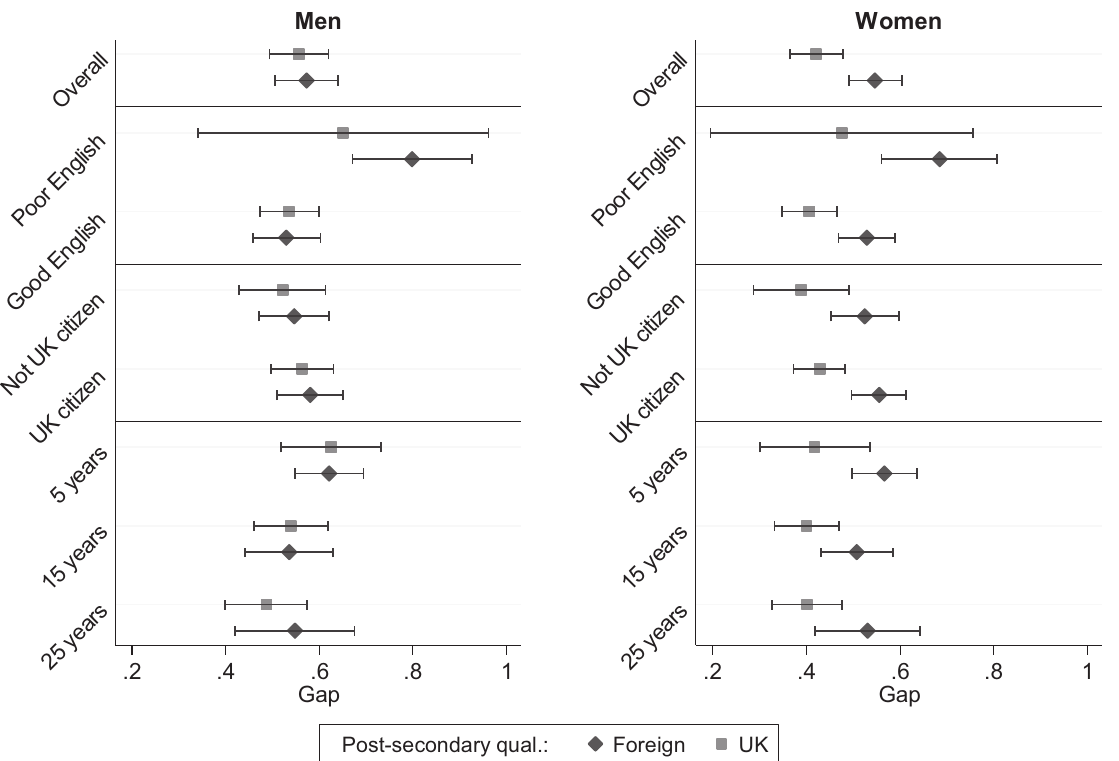
Figure 4. Estimated effect of having foreign or UK post-secondary qualifications over post-secondary qualifications on be- ing over-qualified for migrants. Notes: Showing estimated returns to post-secondary qualifications compared to at most upper secondary for migrants, depending on whether obtained abroad or in the UK, in a baseline model controlling for urbanity, health, family situation, region and year, language skills, citizenship and years of residence (overall), as well as separate models interacting post-secondary qualifications with resp. language skills, citizenship, and years of residence (squared); effect in predicted probabilities estimated at grand